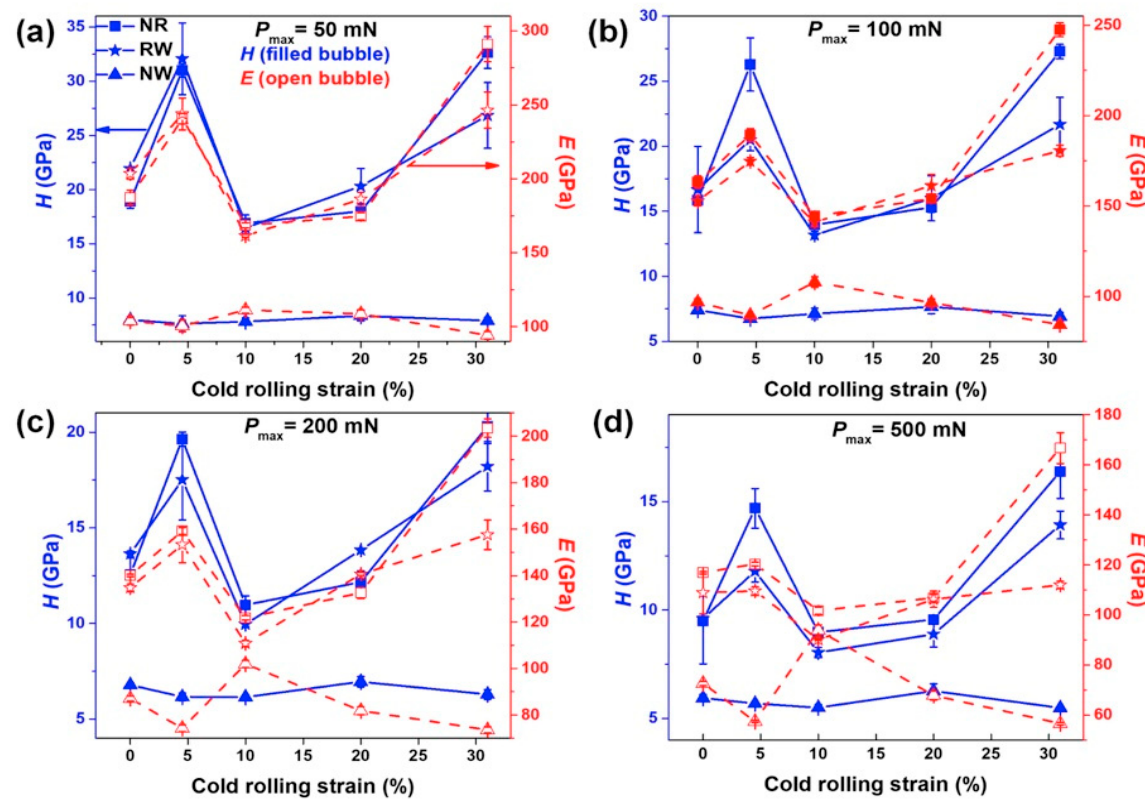
Figure 7. Hardness ( H ) and Young’s modulus ( E ) variation with cold rolling percentage in the NR, RW, and NW planes at P max of ( a ) 50 mN, ( b ) 100 mN, ( c ) 200 mN, and ( d ) 500 mN.